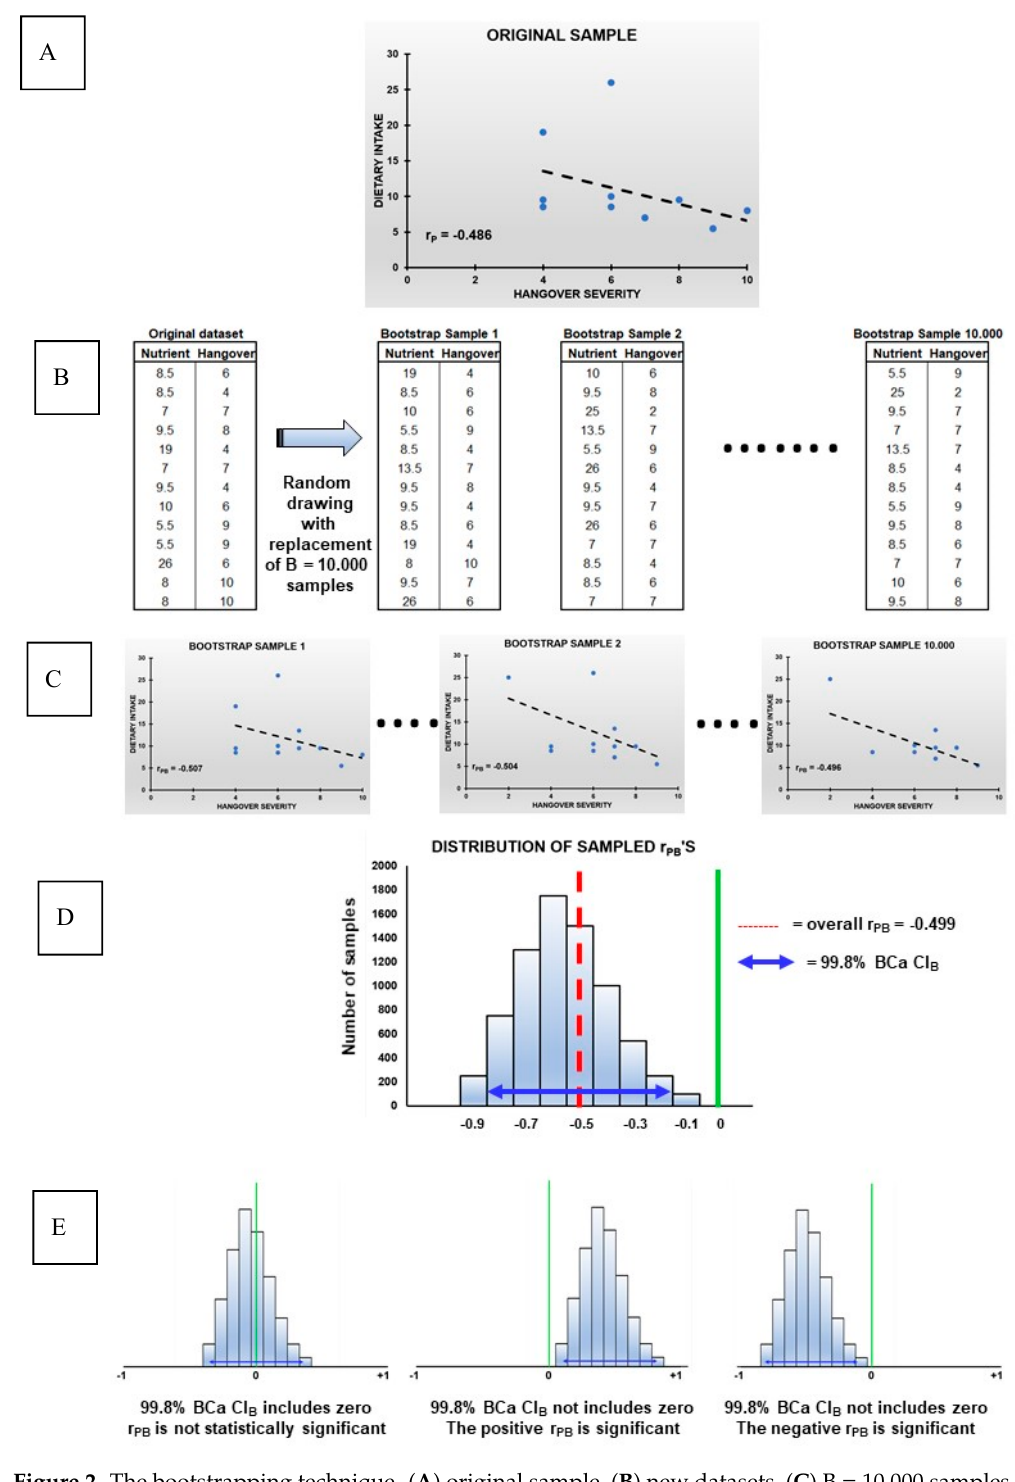
Figure 2. The bootstrapping technique. ( A ) original sample, ( B ) new datasets, ( C ) B = 10.000 samples, ( D ) Composing a histogram of all rPB, ( E ) rPB is considered statistically significant. Abbreviations: r P = partial correlation, r PB = bootstrapped partial correlation, BCa = bias-corrected and accelerated, CI B = bootstrapped confidence interval.